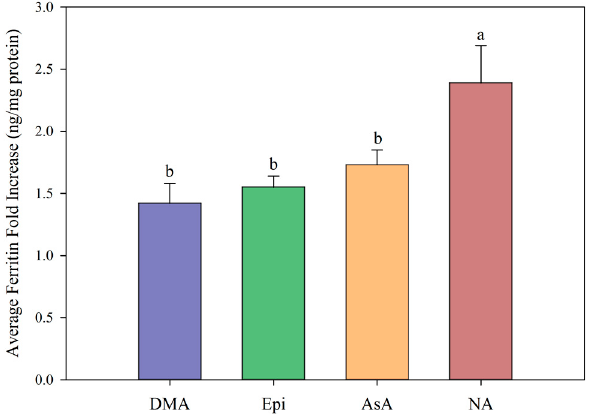
Figure 4. Average fold increase in Caco-2 cell ferritin formation in response to 2’ deoxymugineic acid (DMA, blue), epicatechin (Epi, green), ascorbic acid (AsA, orange), and nicotianamine (NA, red) at Fe:metabolite molar ratios ≤ 1:2 compared to ferritin formation in the presence of Fe alone. Error bars represent standard error of the mean of at least eight replicates. Different letters indicate significant differences between mean fold increase in ferritin formation between metabolites as analyzed by one-way ANOVA with Hsu’s MCB post-hoc test ( p < 0.05).